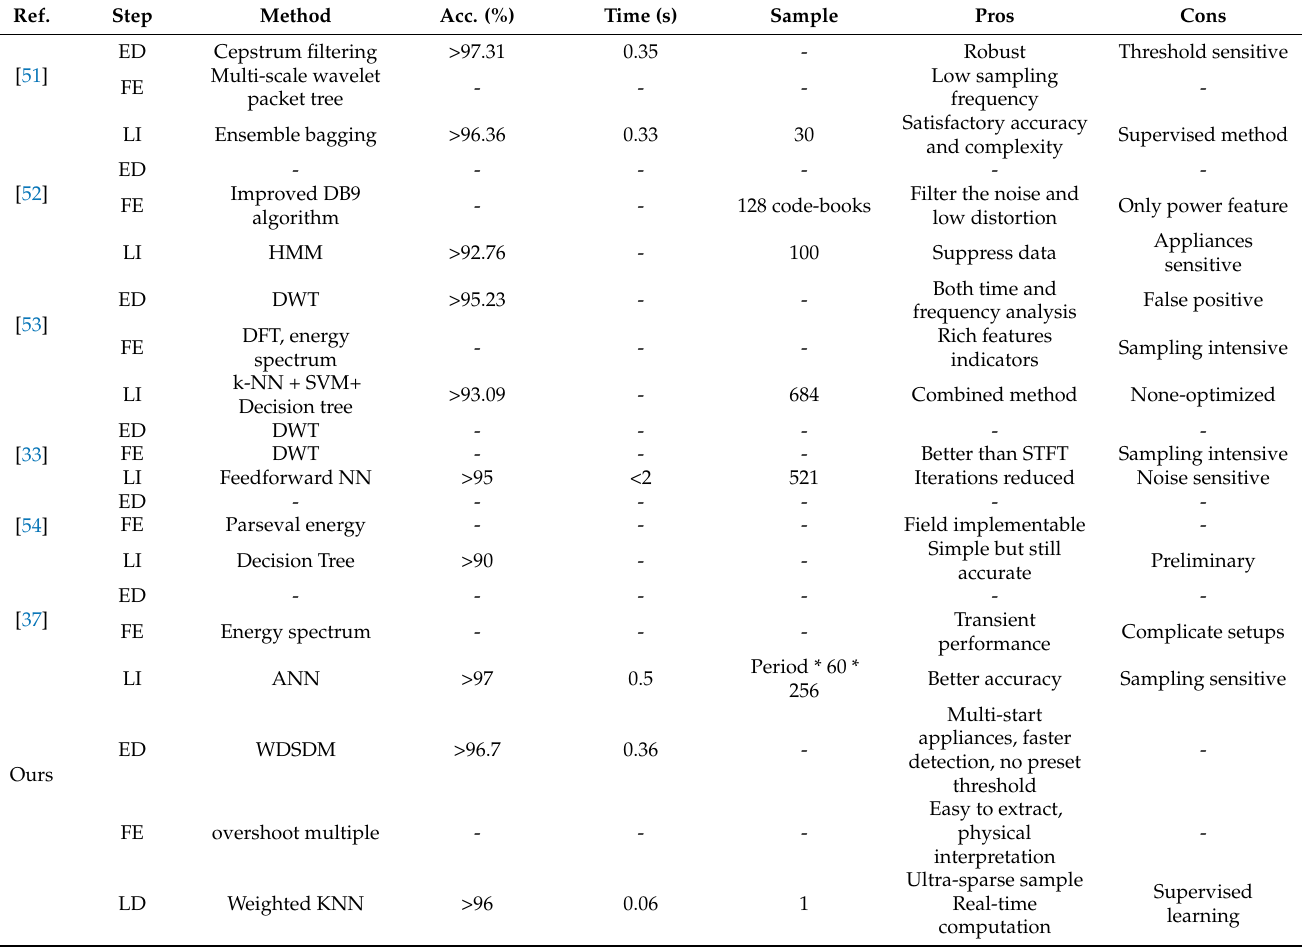
Figure 12. Harmonic comparison of LED and SCR1. Table 9. Comparison of different